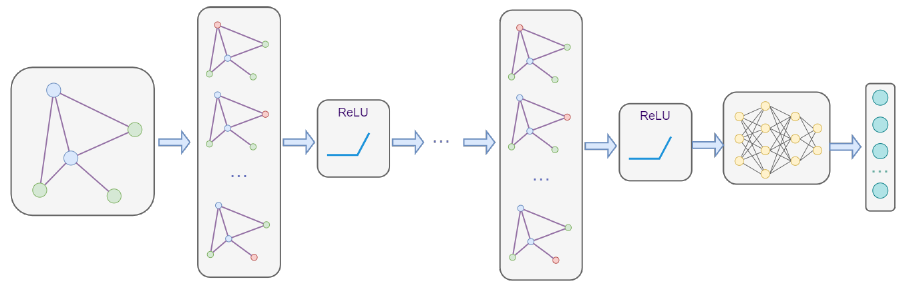
Figure 7. The network structure of the GNN